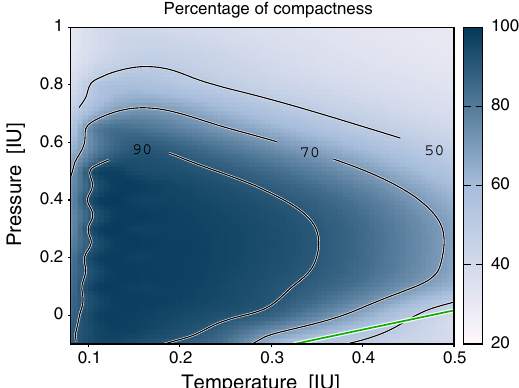
FIG. 6. Average compactness of the designed proteins. The compactness is calculated as the average number of residue-residue contact points, regardless of if they correspond to the native contacts, as a function of T and P . It is expressed as a (color-coded) percentage over the maximum possible number of contacts and averaged over proteins designed at different values of P d and T d . The straight (green) line on the bottom represents the liquid-gas spinodal